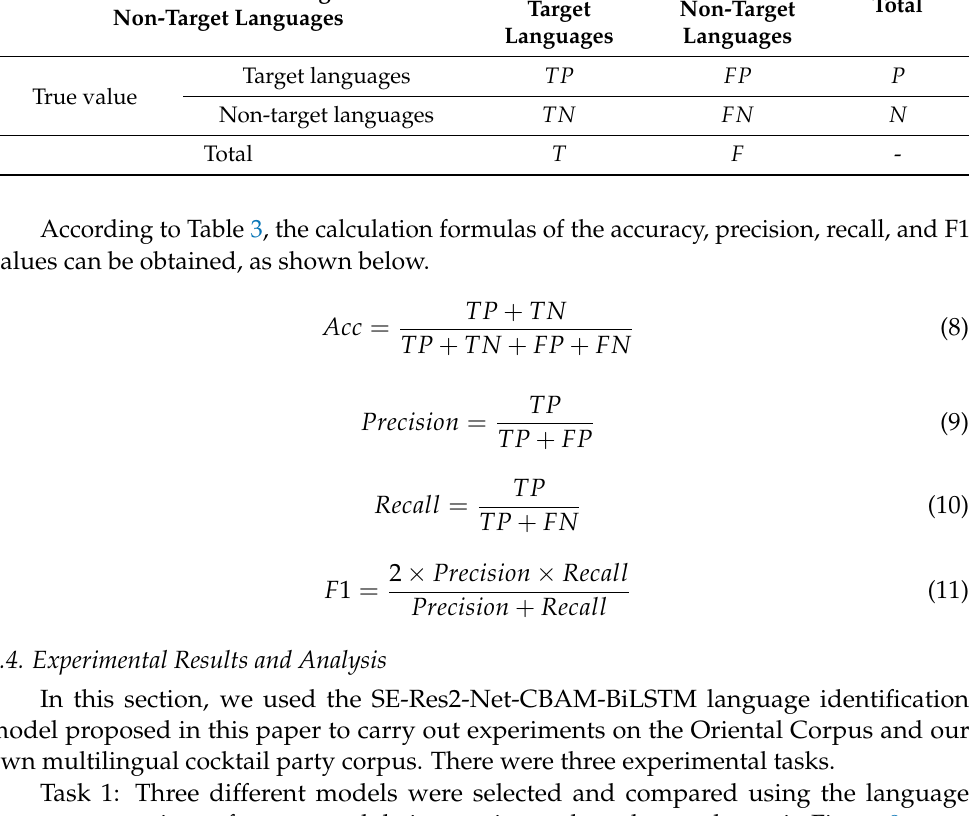
Table 3. Results of statistical identification. Confusion Matrix for Target